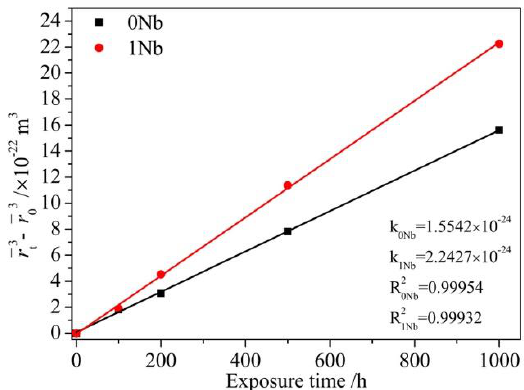
Figure 8. Lifshitz–Slyozov–Wagner (LSW) analysis for γ (cid:48) coarsening. Figure 8. Lifshitz – Slyozov –Wagner (LSW) analysis for γ´ coarsening.